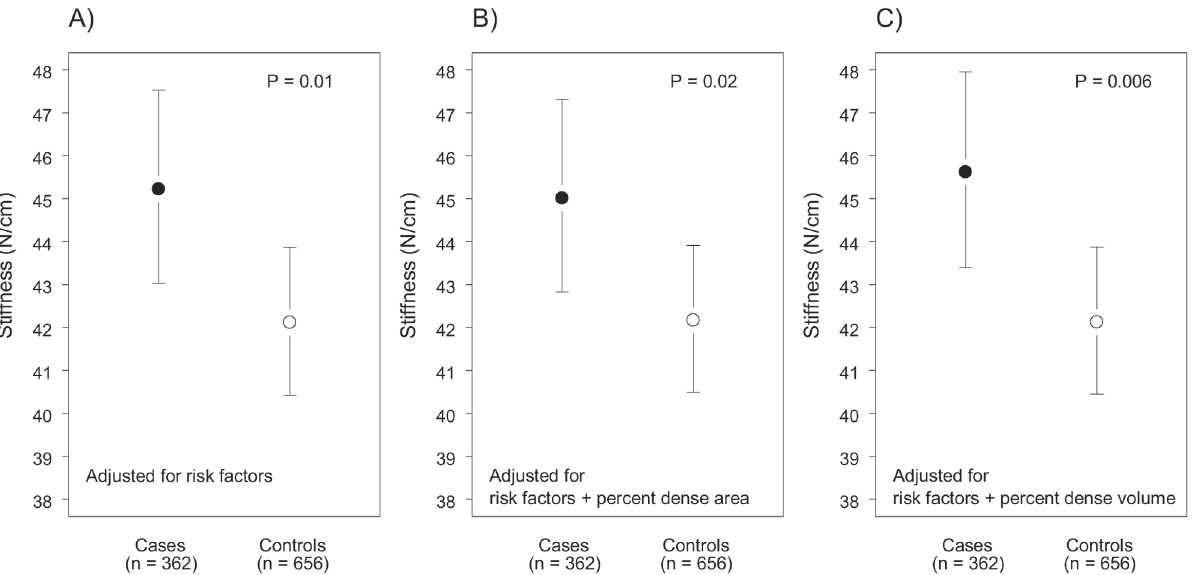
Figure 3. Least square means of stiffness in cases and controls, adjusted for risk factors. Risk factors include: age at mammogram (linear and quadratic terms), age at birth of first child, weight (kg), height (cm), menopausal status (pre/post) and parity (parous/nonparous). Stiffness (N/cm) was natural logarithm transformed in the analysis. The least square means shown are back transformed to the original scale. Bars show 95% confidence interval. P is the p-value for the significance of case control difference. When adjusted for percent dense area, square root transformation was used and model includes linear and quadratic terms. When adjusted for percent dense volume, cubic root transformation was used and model includes linear and quadratic terms.